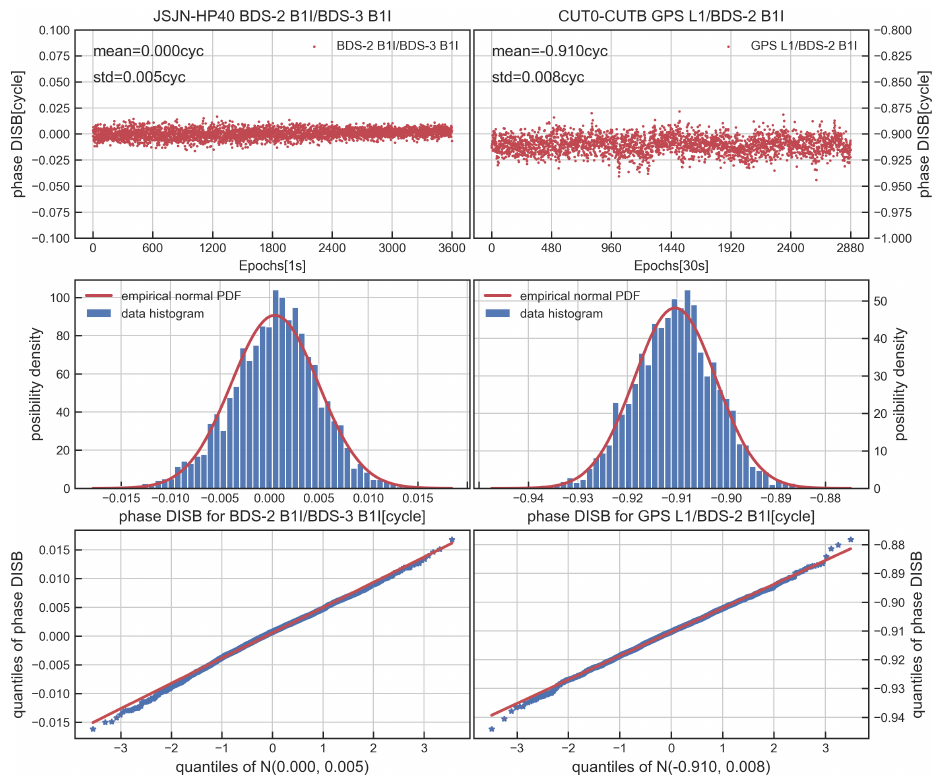
Figure 8. Time series, distribution and QQ plot of BDS − 2 B1I/BDS − 3 B1I phase DISB for JSJN − HP40 ( left ) and GPS L1/BDS − 2 B1I phase DISB for CUT0 − CUTB ( right ). Table 2. Test statistics and critical value for phase